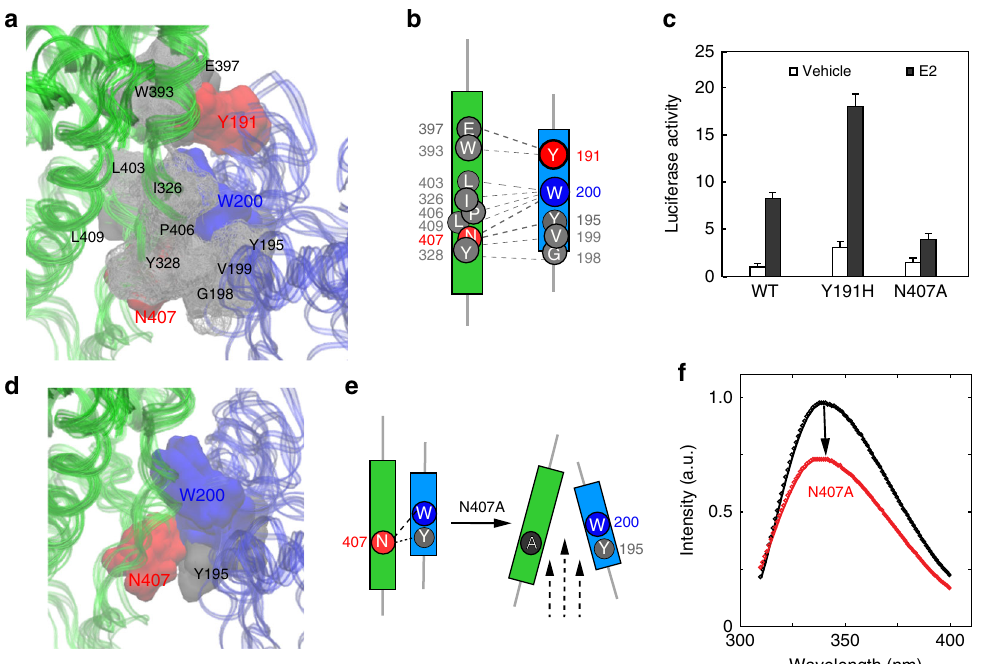
Fig. 3 The DBD – LBD interface and its functional relevance. a Close-up view of the DBD – LBD interface. Highlighted are contact residues with mutation sites (red) and the fl uorescence site at W200 (blue). b Cartoon of interfacial residues. Dashed lines indicate a probability >75% of making a residue contact within the structure ensemble. c Effect of interfacial mutations on ER transcription activity. The Y191H mutation increases the transcription luciferase activity of the receptor, while N407A reduces the activity. Triplicates were carried out and standard deviations were indicated. d Tryptophan fl uorescence site at W200. Shown are interactions between hydrophobic residues N407 (red circle), Y195 (gray circle), and W200 (blue circle) at the interface. e A schematic representation of tryptophan surroundings upon mutation. Illustrated are possible structural changes near W200 before and after mutation. f Quenching of tryptophan fl uorescence. Emission fl uorescence intensity is reduced in mutant N407A. A protein concentration of 0.1 mg/ml was used before and after mutation. Excitation at 295